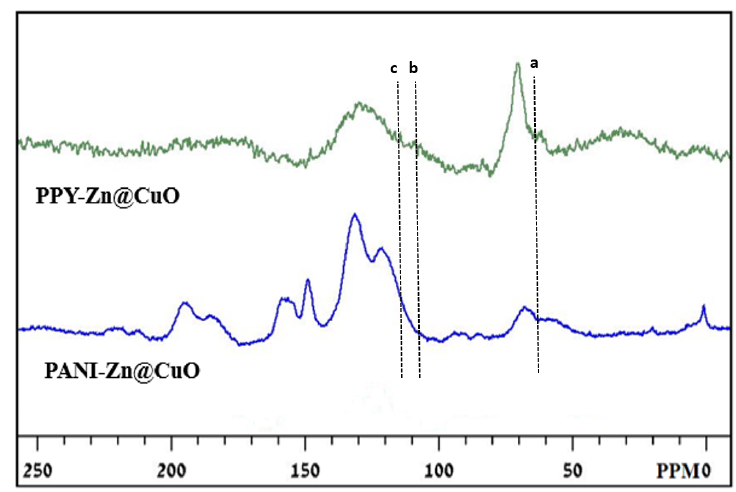
Figure 3. Solid-state 13 C NMR spectra of PPY-Zn@CuO and PANI-Zn@CuO macro-nanocomposites.